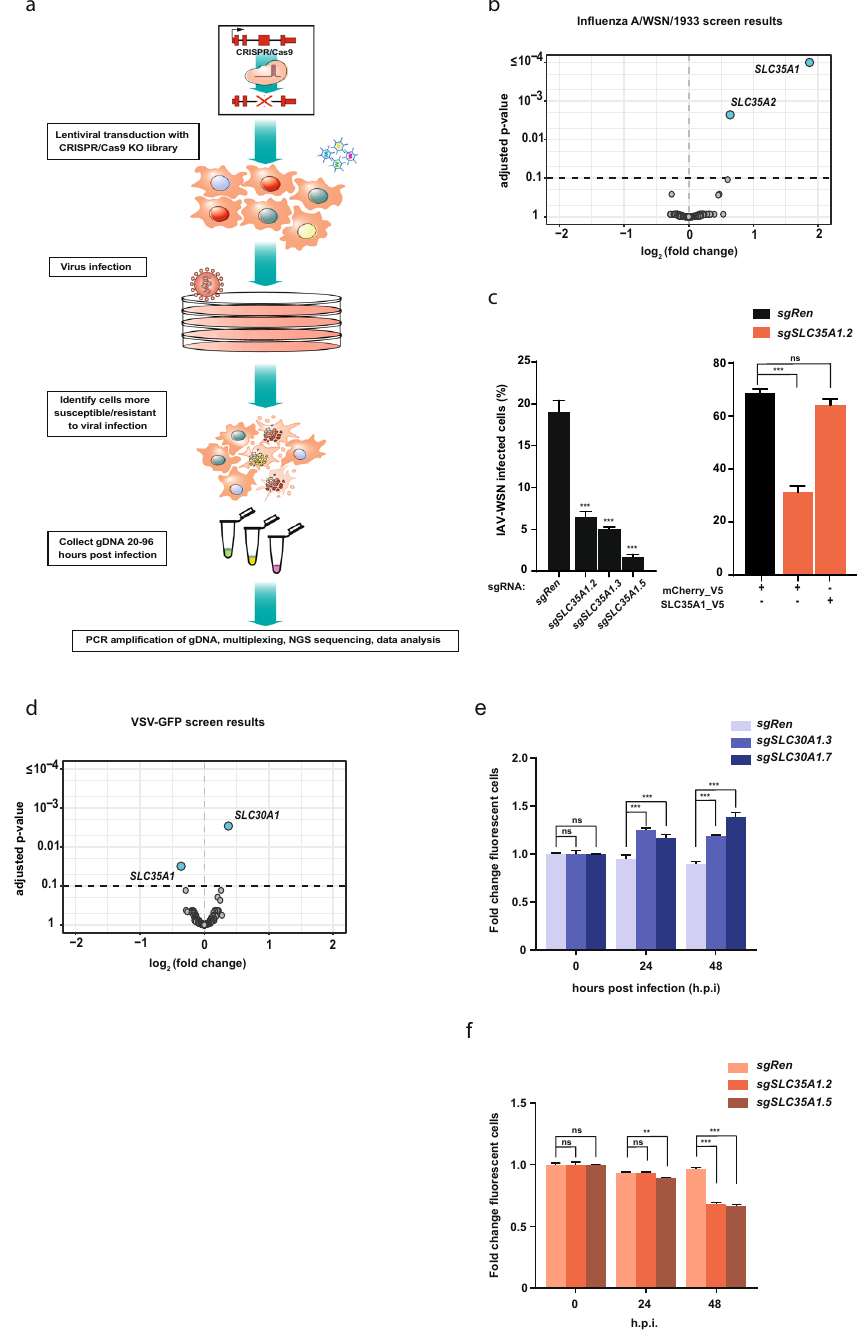
Figure 1. An SLC-focused genetic screen identifies known and novel host factors for IAV and VSV. ( a ) Schematic overview of the screen workflow. ( b ) Volcano plot of the genetic screen results in A549 cells infected with IAV- WSN/1933 at 96 h.p.i. ( c ) Quantification of flow cytometry-based viral replication assay for selected hits. A549 cells carrying sgRNAs targeting SLC35A1 or Renilla luciferase control as well as cells expressing SLC35A1 cDNA were infected with IAV-WSN/1933 at MOI 0.01 and 24 h.p.i. the number of the infected cells was assessed after staining with anti-Influenza Nuclear protein antibody coupled to AF488. ( d ) Volcano plot of the genetic screens results in A549 cells infected with VSV-GFP at 48 h.p.i. ( e , f ) Multicolor competition assay (MCA) of SCL30A1 ( e ) or SLC35A1 ( f ) knockout cells and Renilla controls. Cells were mixed at 1:1 ratio, infected with VSV-rWT at MOI 5 and cultured until the indicated time points. The percentage of mCherry + ( Renilla control) and eGFP + (gene of interest) cells in the live population (FSC/SSC) were assessed using flow cytometry. Statistical significance was calculated using one-way ANOVA ( c ) and two-way ANOVA ( e , f ) with Dunnett’s test. Unless otherwise indicated, adjusted P-values in relation to the sgRen control are shown. Data are represented as mean ± SD of one representative experiment out of at least two independent replicates. ** p ≤ 0.01; *** p ≤ 0.001; ns: not